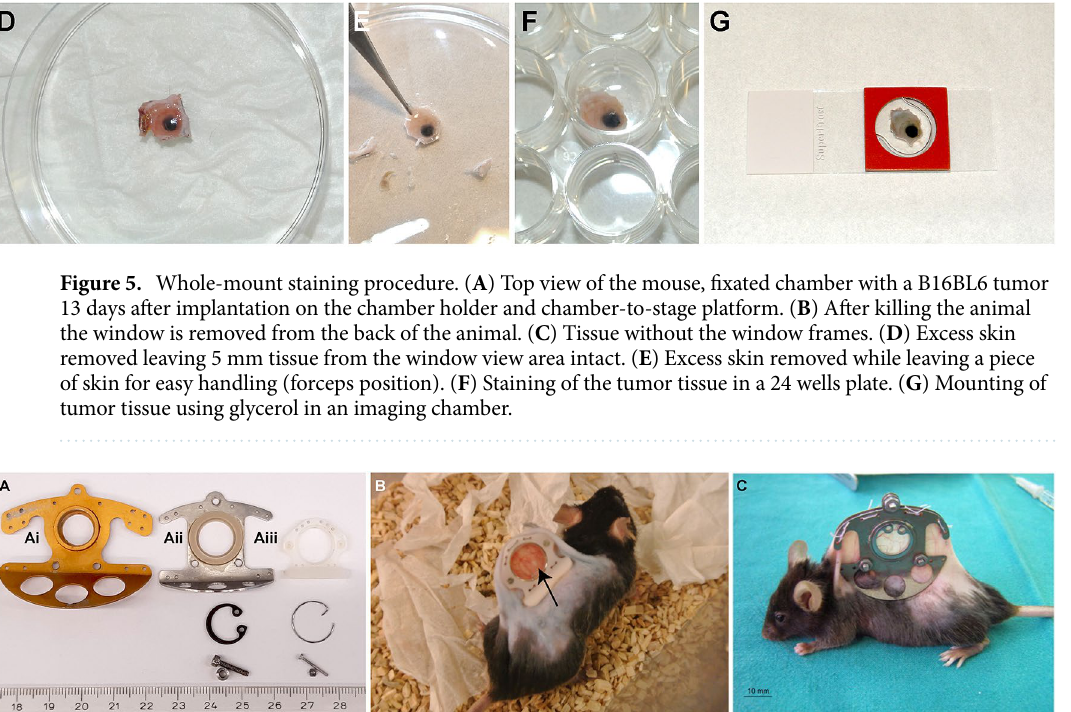
Figure 6. Differences in frame design. ( A ) Shown is the window frame developed by Jain et al. ( Ai ), our first adaptation ( Aii ) similar to the design of Dewhirst et al. 15 and our current design ( Aiii ), including retainer ring, screw and nut. ( B ) Photograph of a conscious 25.1 g (excl. window) animal 2 days after implantation with a LLC tumor (arrow). ( C ) Photograph of an animal with a traditional window chamber taken from the publication from Regelin et al. 14